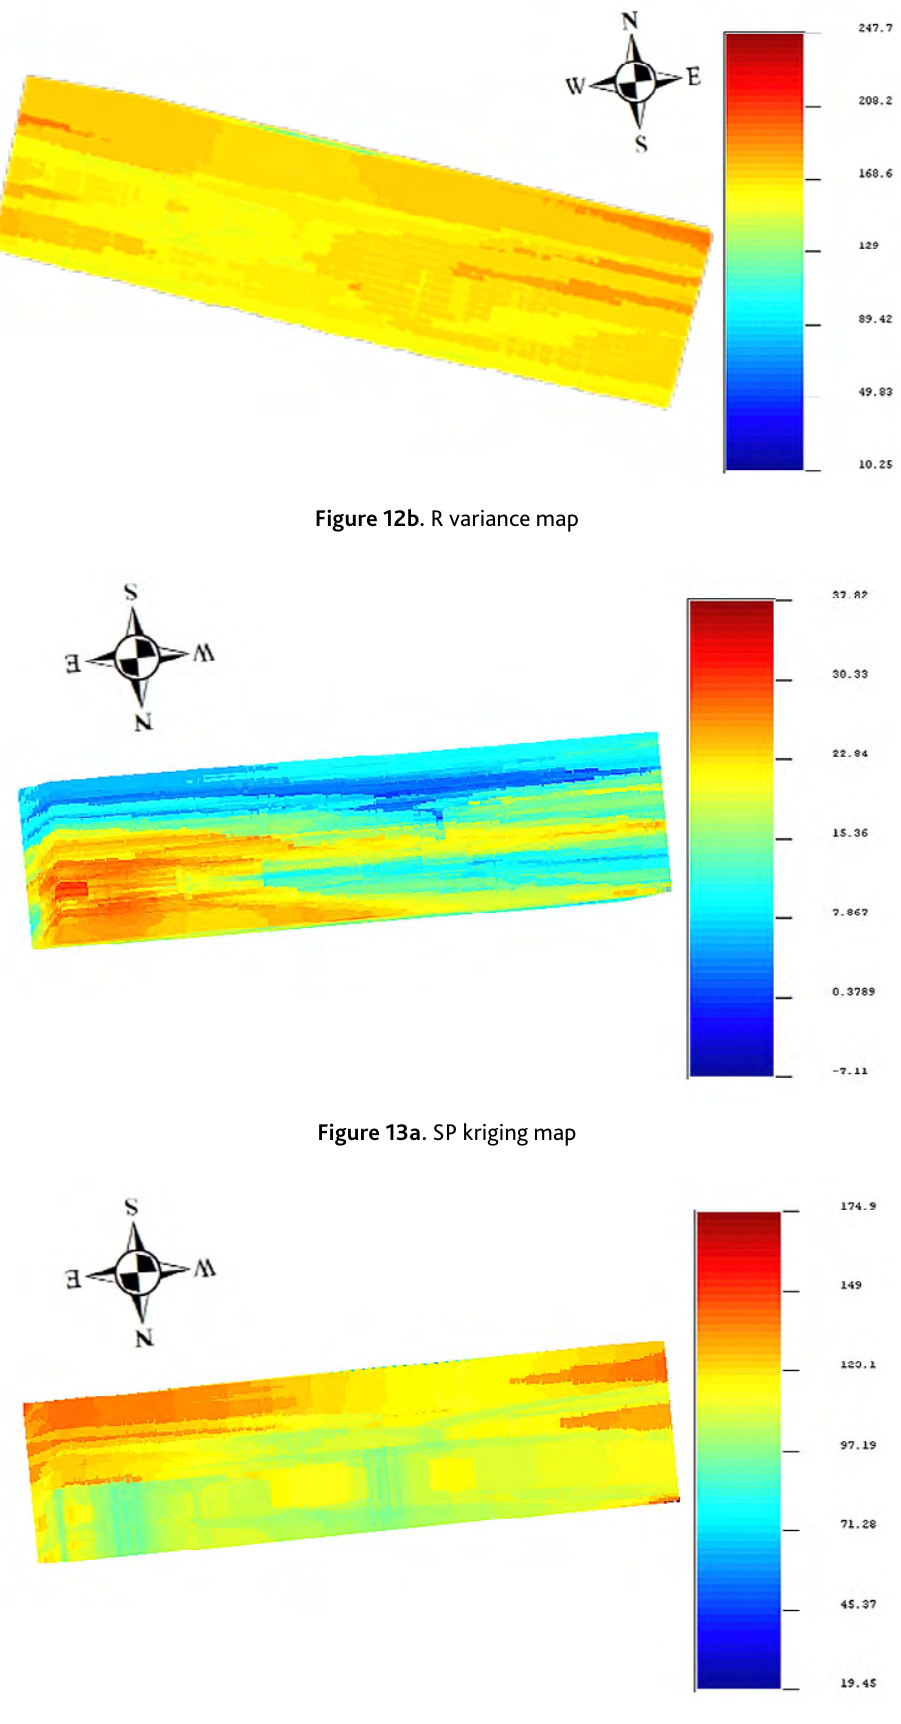
Figure 13b. SP variance map